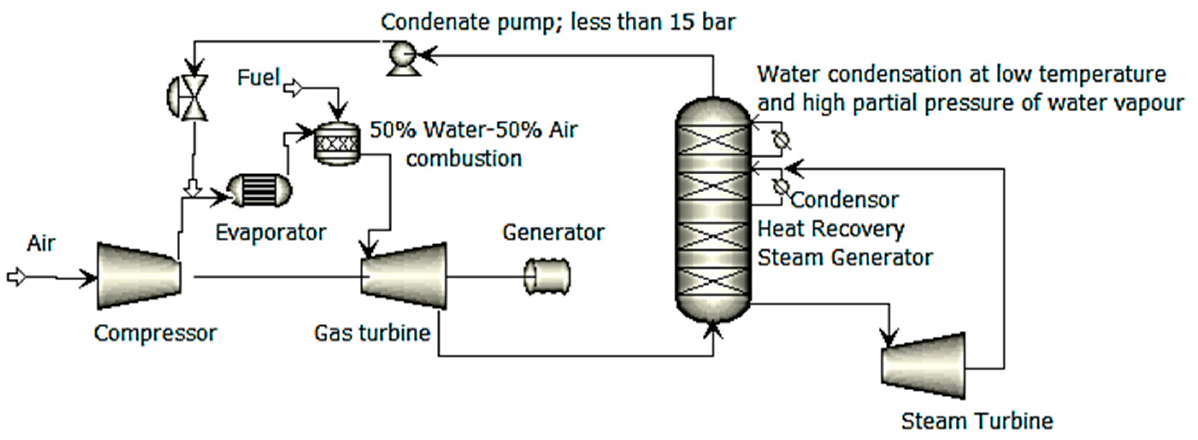
Figure 9. Simplified plant scheme of the low-temperature heat combined (L.O.T.H.E.C.O.) cycle.